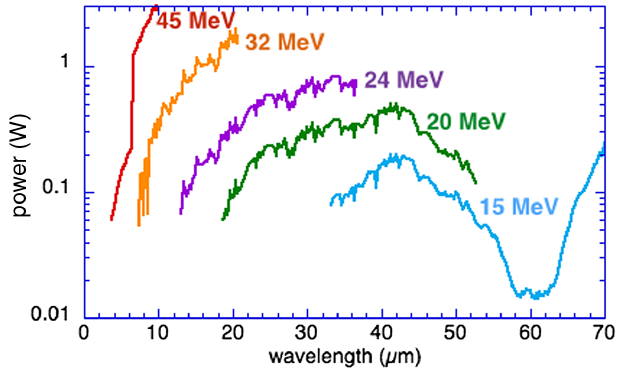
FIG. 12. Laser power P T versus waveguide length d x